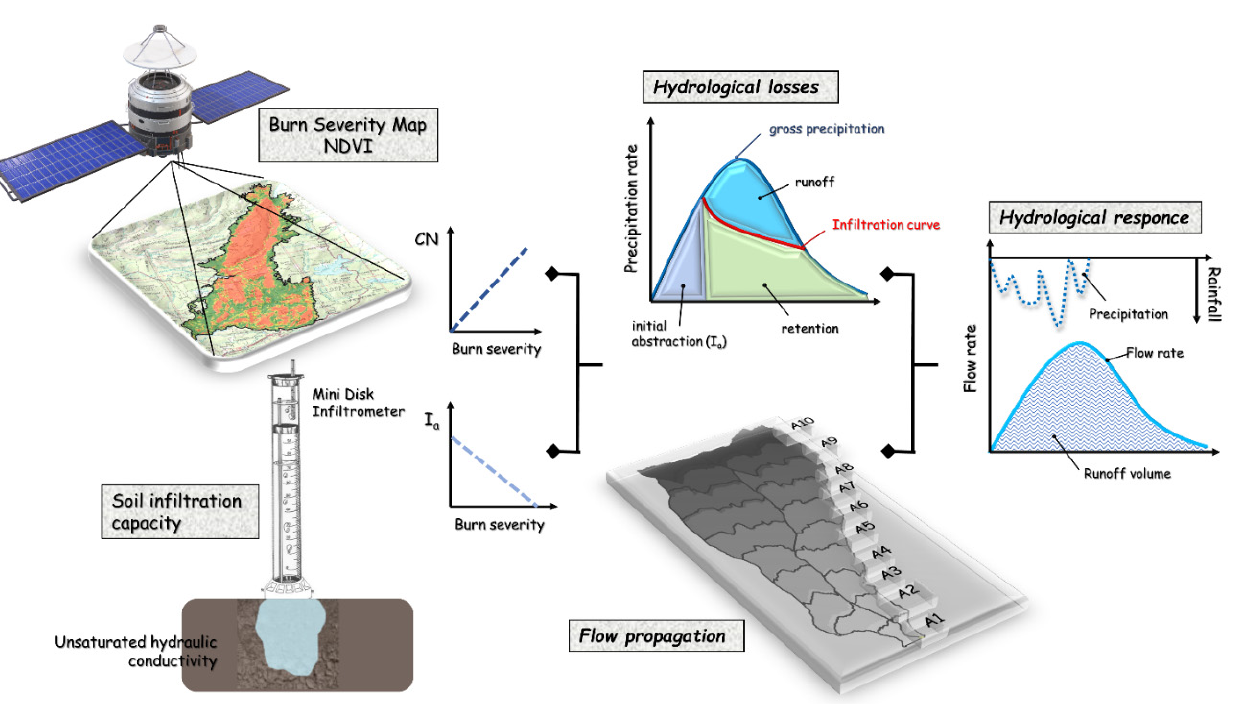
Figure 2. Steps of the integrated approach.